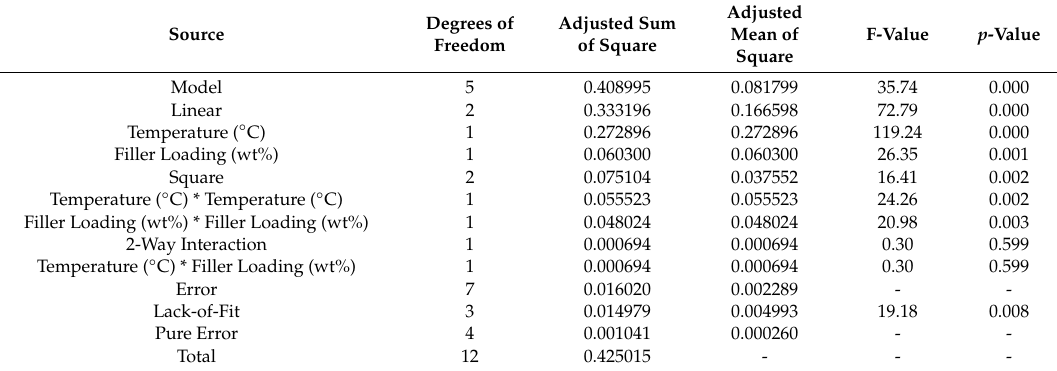
Table 4. ANOVA table which represents the statistical significance of the data designed according response surface methodology (RSM) with the FCCD method.